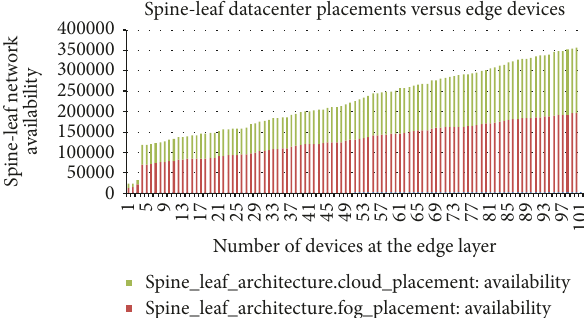
Figure 6: Spine-leaf DCN placement for services